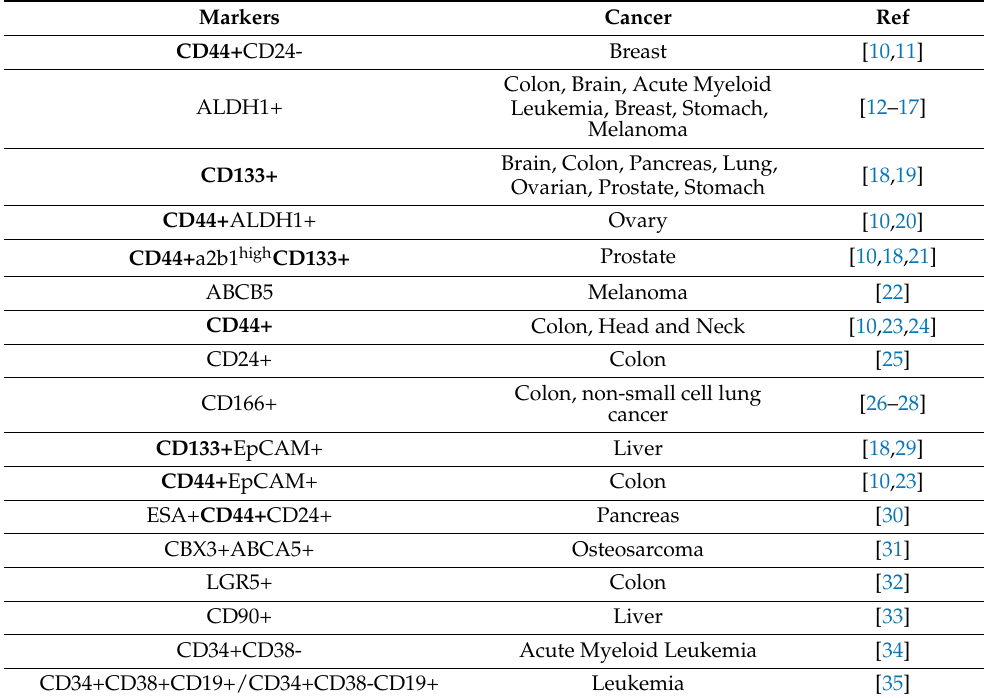
Table 1. CSC-related markers in different cancers. Some of them (indicated in bold) are connected with iron